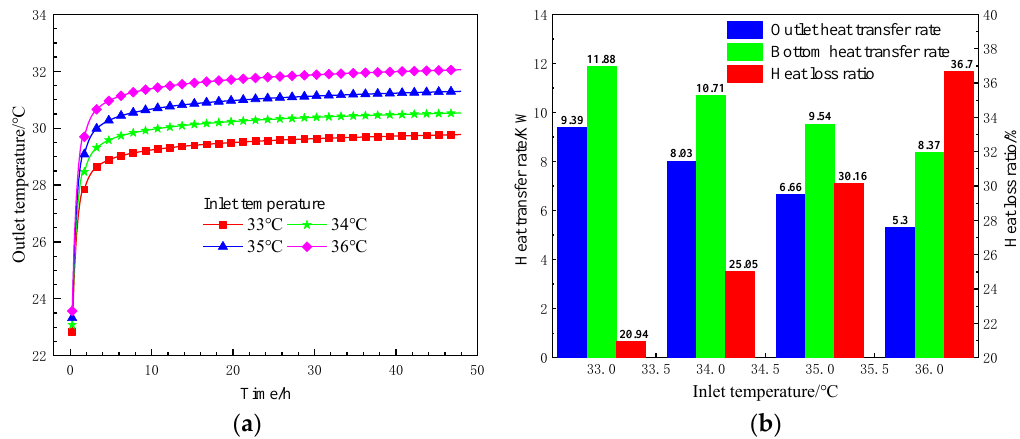
Figure 14. Sensitivity of outlet temperature and heat transfer rate to inlet temperature. ( a ) Sensitivity of outlet temperature to inlet temperature. ( b ) Sensitivity of heat transfer rate and heat loss ratio to inlet temperature.